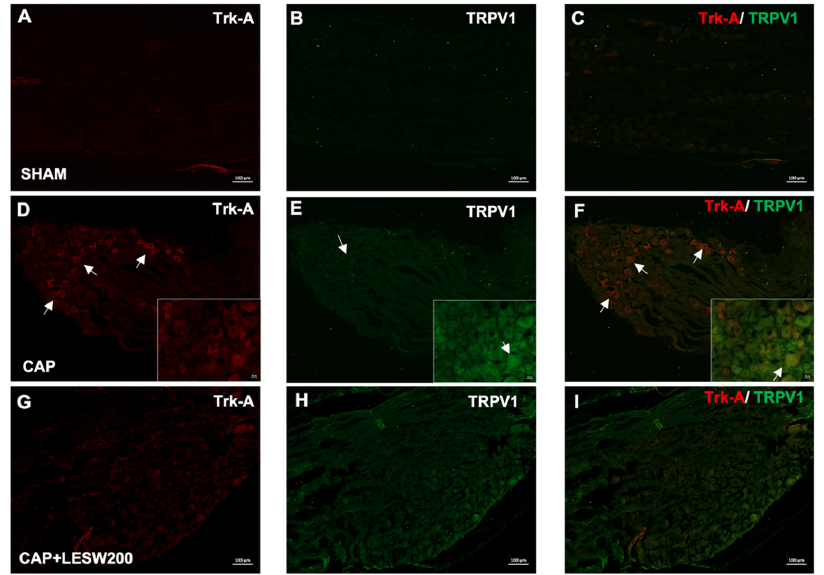
Figure 2. Co-localization of Trk-A and TRPV1 immunofluorescence staining in L6 DRG on day three after intraprostatic capsaicin (CAP) injection. Double immunostaining showed that Trk-A immunoreactivity (red staining) was co-localized with TRPV1(green staining). Most of the TRPV1 positive neurons expressed Trk-A (white arrow). intraprostatic capsaicin (CAP) injection-induced increment of TRPV1 and Trk-A immunoreactivity in L6 DRG, and this effect was ameliorated by 200 shocks of Li-ESWT. ( A – C ) after vehicle injection; ( D – F ) after intraprostatic capsaicin (CAP) injection. ( G – I ) intraprostatic capsaicin injection with 200 shock wave treatment. Scale bars indicate 100 μm.